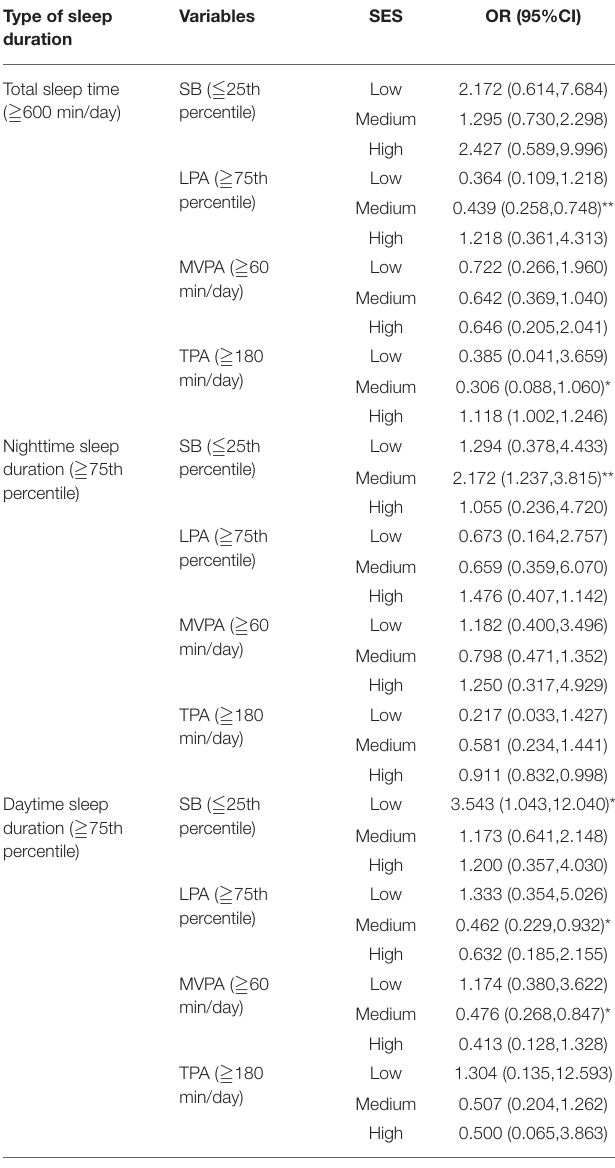
TABLE 5 | Protective and risk factors of adequate sleep for children of different social economic status.